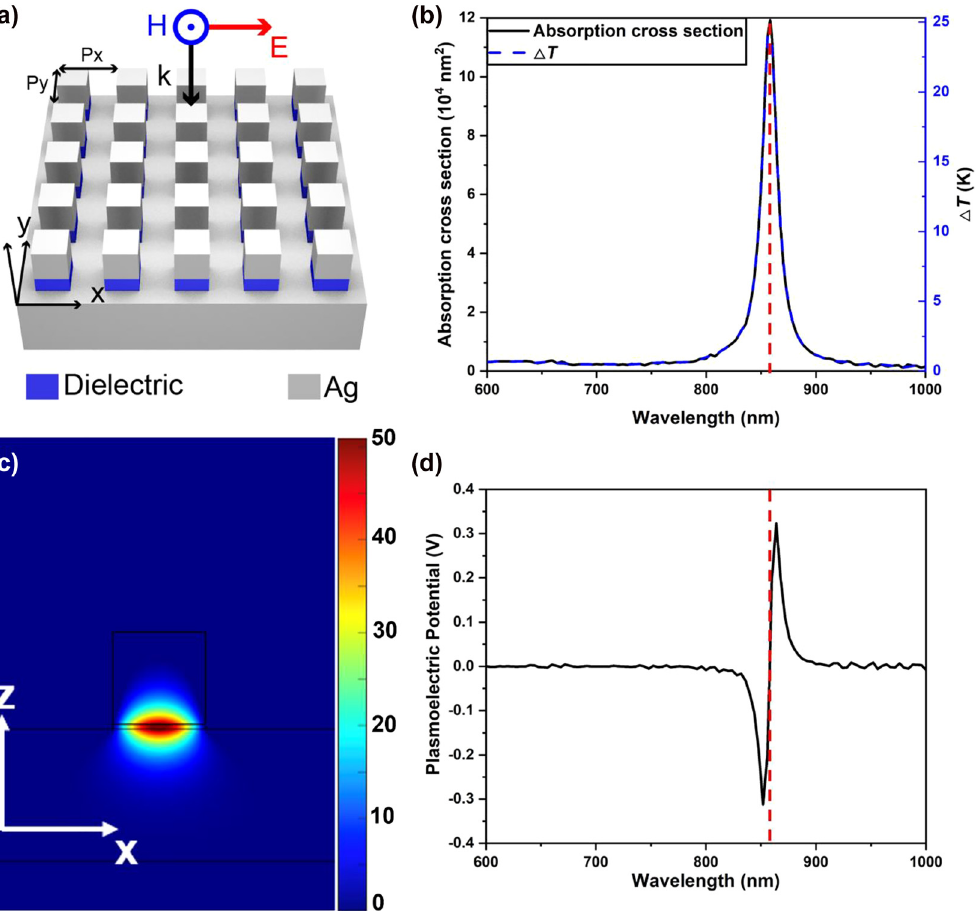
Figure 4: Temperature rise and PEP induced by guided mode from perfect absorbers. (a) Schematic of anarrayof70nm × 70nm × 70nmsilver nanocubesseparatedfroma silversubstratebya4nmthickdielectric spacer(inblue). Thepitchperiodis350nminboth x -and y -directions.(b)Simulatedabsorptioncross-sectionspectrum(leftaxis)andcorrespondingtemperature rise(rightaxis)forthesystemin(a).(c)Simulatedmagnetic fi elddistributionforthegap-plasmonguidedmodeat λ =860nmwhichismarkedby dashed red lines in (b) and (d). The color map represents | H / H 0 | where H 0 is the magnitude of the incident magnetic fi eld component. (d) Calculated PEP spectrum for the system in (a) under an illumination spot of 0.2 cm in diameter and uniform intensity of 200 W/cm 2